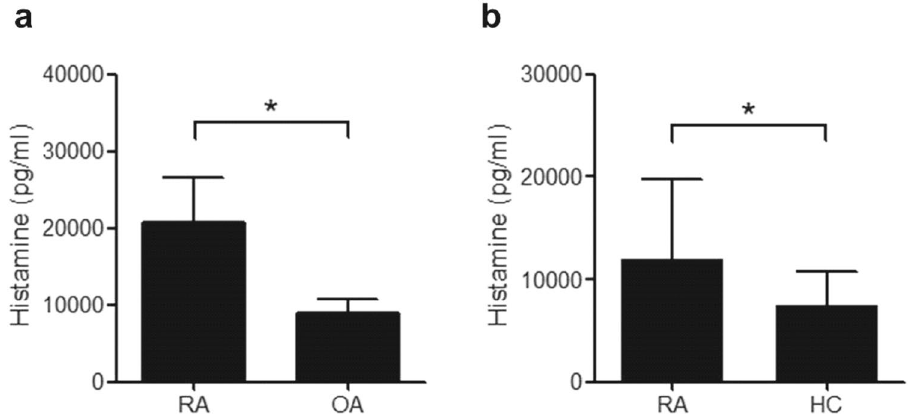
Figure 1. The synovial fluid (SF) and serum concentration of histamine in RA patients. ( a ) The SF concentration of histamine in RA and osteoarthritis patients was measured using ELISA. ( b ) The serum concentration of histamine in RA patients and healthy controls was measured using ELISA. The data represent the mean ± SEM of three independent experiments. * P < 0.05. RA; rheumatoid arthritis, OA; osteoarthritis, HC; healthy